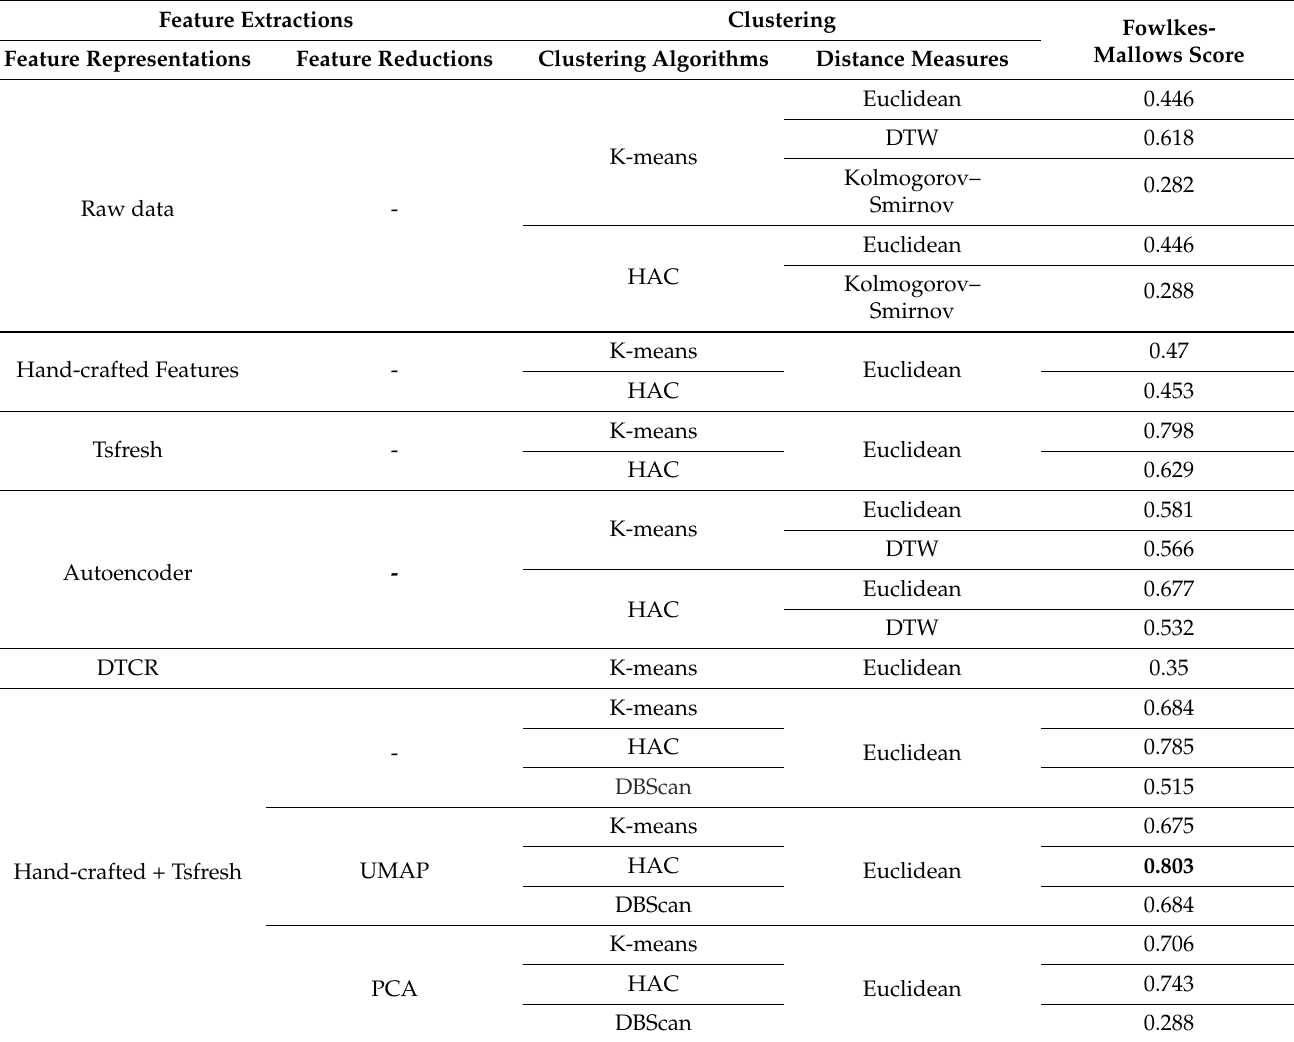
Table 1. Clustering